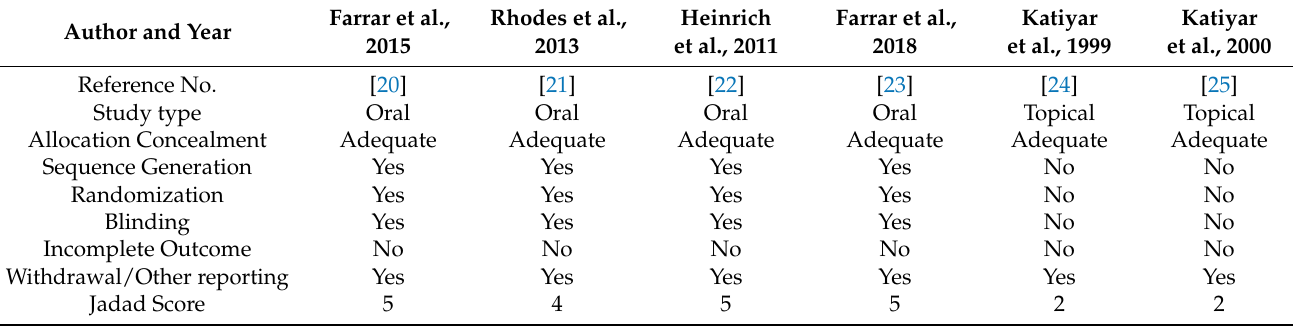
Table 2. Assessment of validity, risk of bias, and Jadad score of the included eligible studies evaluated in the meta-analysis. Author and